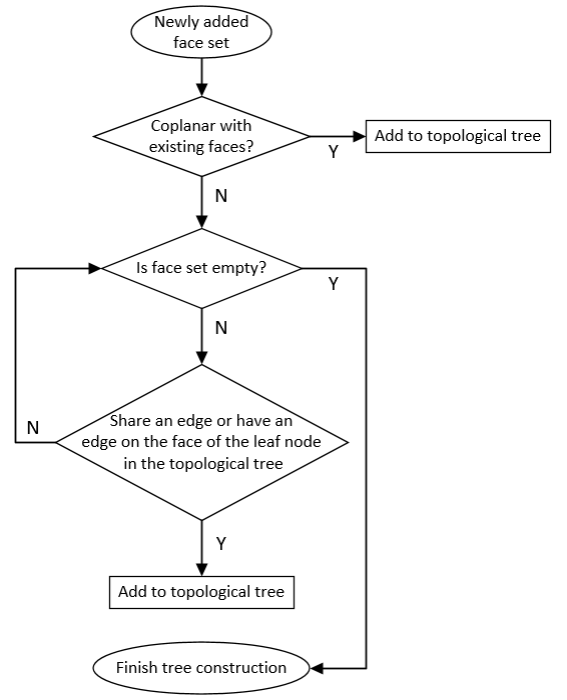
Figure 16. Openings detected by topology